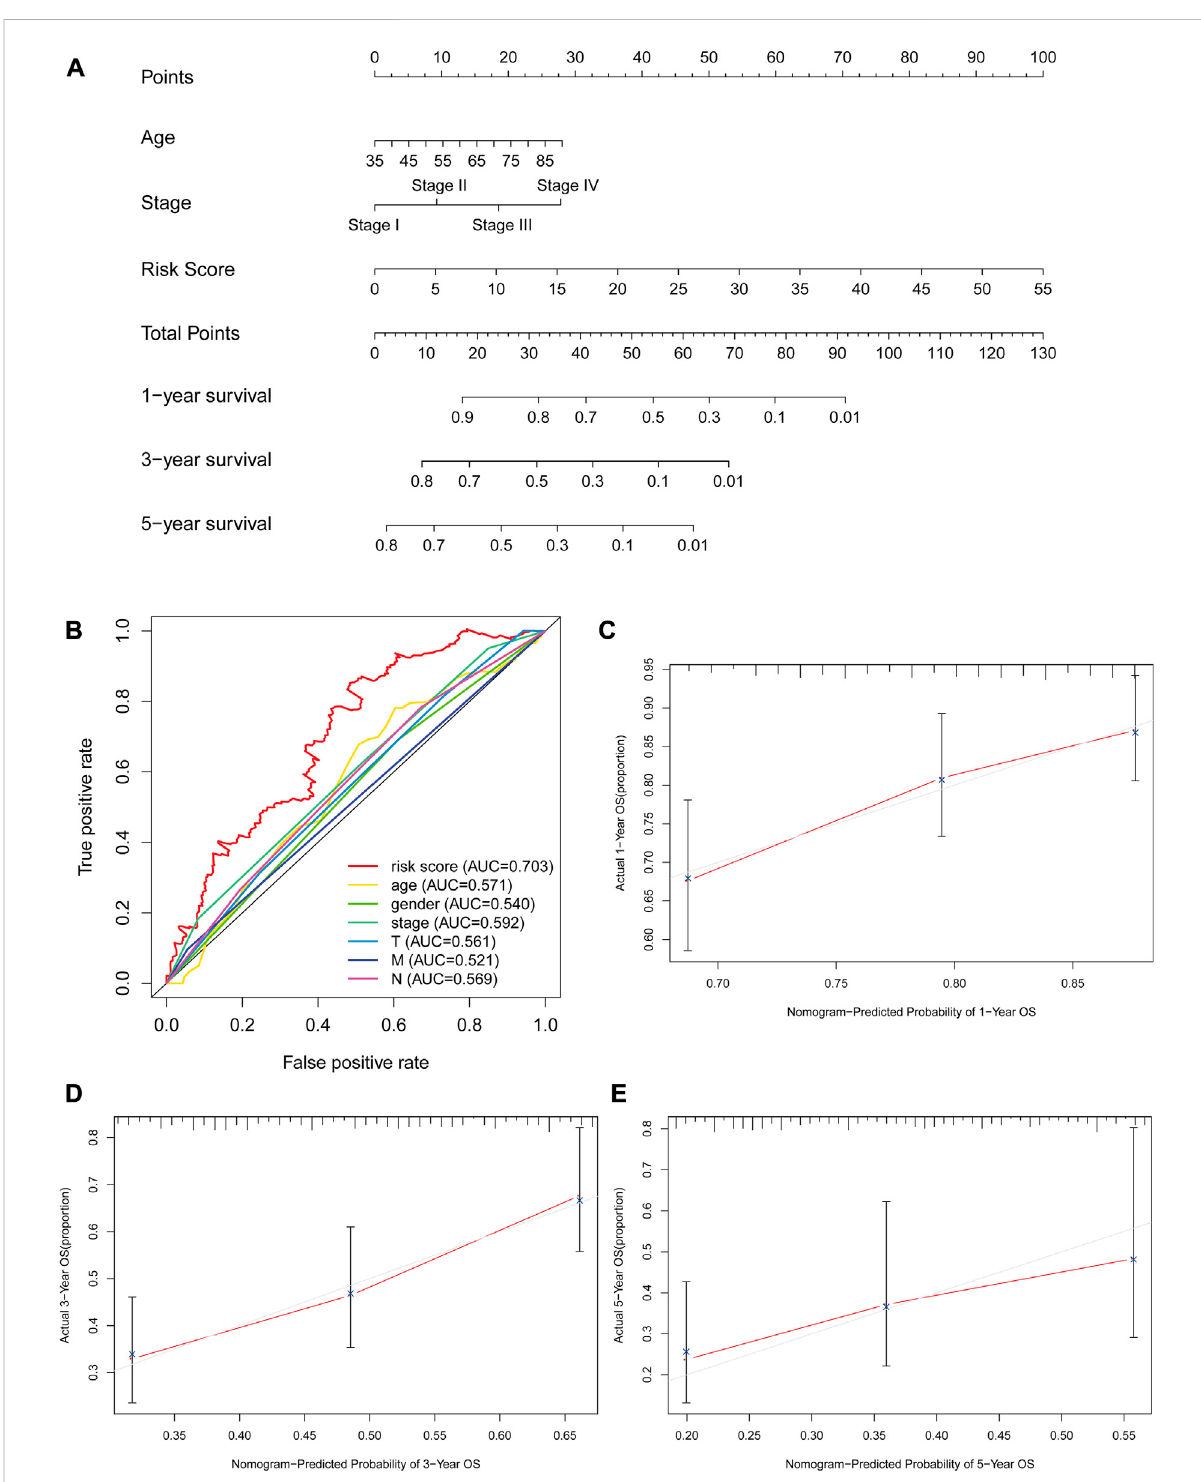
FIGURE 7 Theevaluationofprognosticmodelsbasedonsevenglycolysis-relatedlncRNAs. (A) Thenomogramof1-,3-and5-yearOSbasedonriskscore, age, and TNM stage. (B) The ROC curves analysis based on risk score and the clinicopathologic parameters; (C – E) The calibration plots of 1-, 3- and 5-yearOS forevaluatingtheconcordance betweenthepredictedandthestandardOSfortheprognosismodel.Thecloserthecalibrationcurve(red line) is to the standard curve (grey line), the better the prediction model ’ s